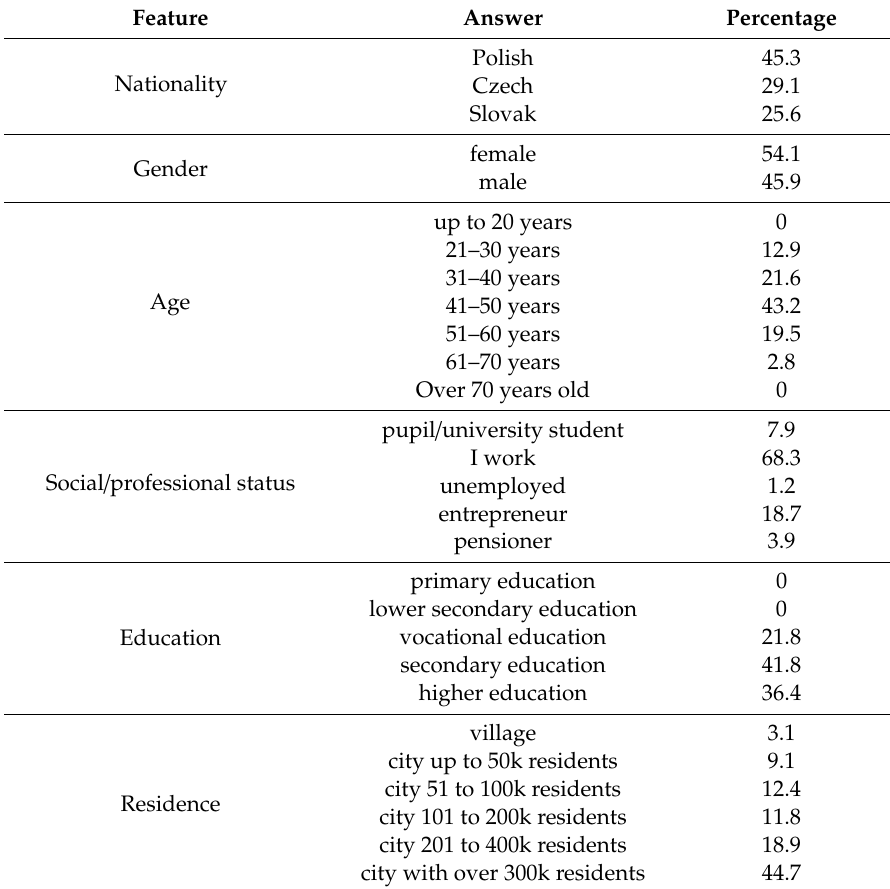
Table 2. Characteristics of the respondents (own